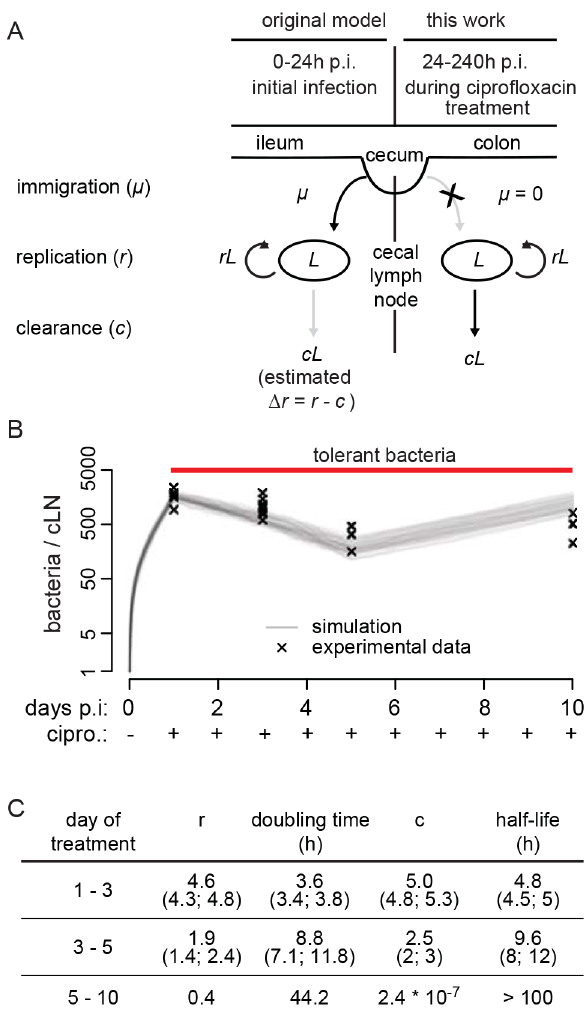
Figure 4. S. Tm WITS infection and a modeling reveal slow growth of tolerant bacteria. (A) Schematic representation of the stochastic birth-death process modified by immigration and its parameterization (for details, see Materials and Methods). During the first 24 h p.i., we analyzed cLN colonization dynamics in absence of ciprofloxacin. Ciprofloxacin treatment was started by 24 h p.i. and continued until day 3, 5, or 10, as indicated. The model for analyzing the latter data is displayed on the right side. (B) Mice were infected with S. Tm WITS and treated with ciprofloxacin (2 6 62 mg/kg/d by gavage) from day 1 p.i. until the indicated end of the experiment (day 1, n =49; day 3, n =28; day 5, n =28; day 10, n =28 data points). CFU determination and analysis of tag abundance using rtqPCR (experimental data, Table S2) was used to fit the mathematical model. Graphic display of experimental data (x) and 100 simulations (grey lines). (C) Parameters (with confidence intervals) derived from fitting the mathematical model to our experimental data. r , replication rate; doubling time, ln2/ r 6 h; c , clearance rate; half-life, ln0.5/ c 6 h.